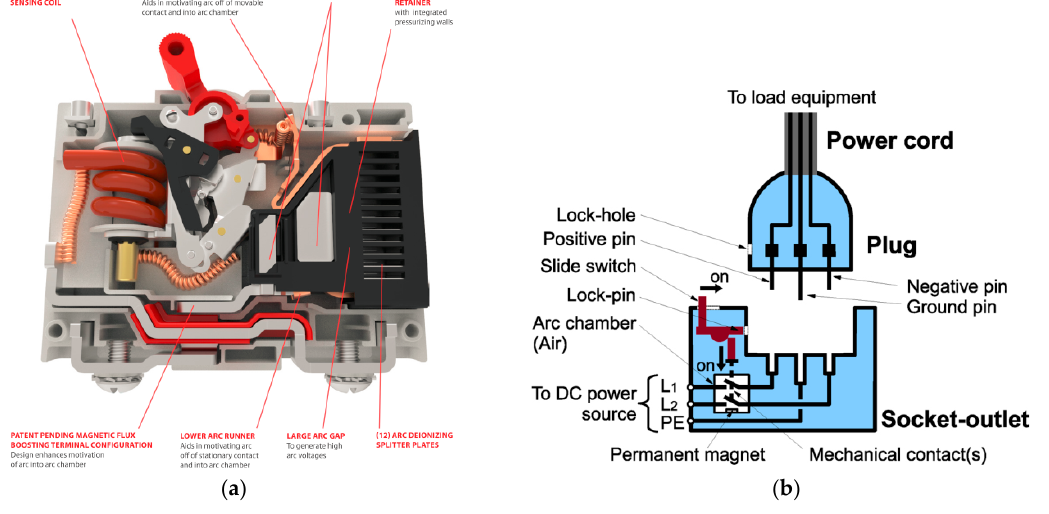
Figure 5. ( a ) Design features of Carling Tech DC circuit breaker (© of Carling Tech) [45]; ( b ) configuration of DC plug and socket outlet system (© of NTT Facilities)